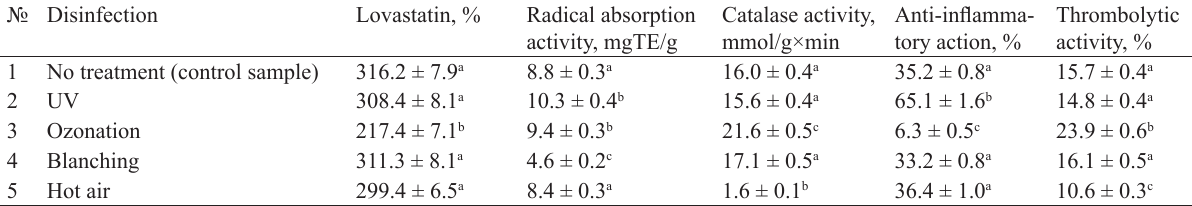
Table 2 Effect of various methods of preliminary disinfection on the bioactive properties of freeze-dried product (M ± m) № Disinfection